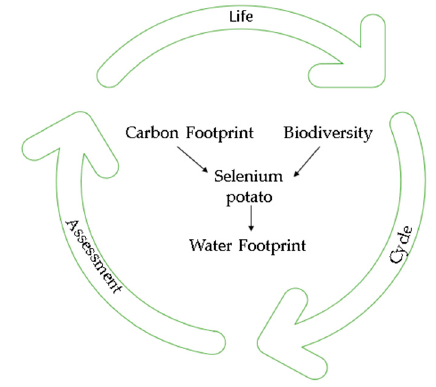
Figure 3. Life-cycle assessment (LCA) of selenium potato.